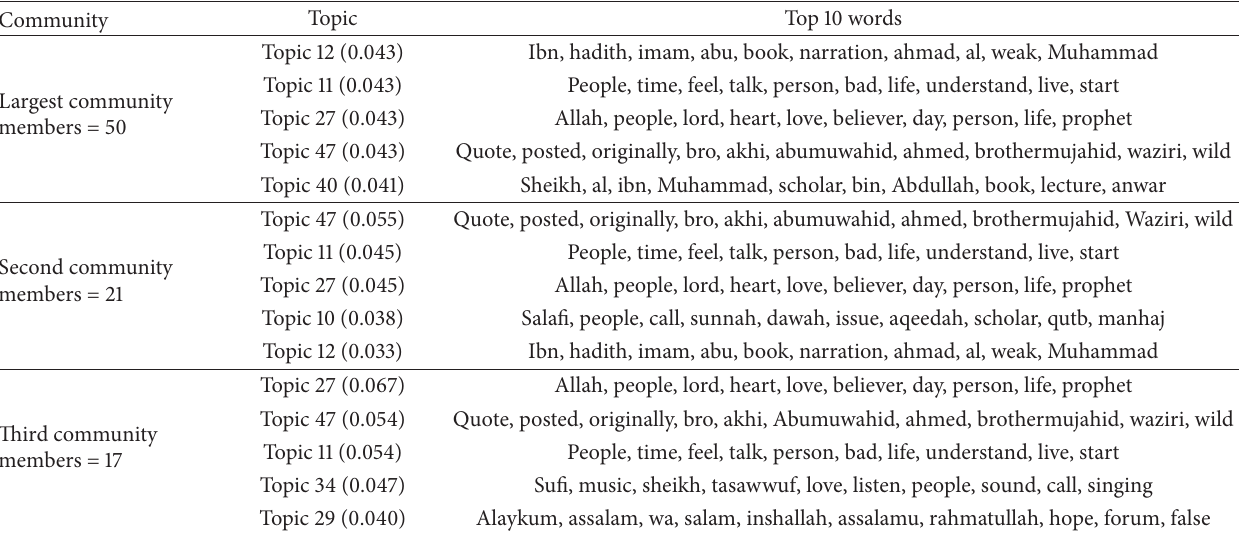
Table 2: Three largest communities for 2005-VC (0.1).